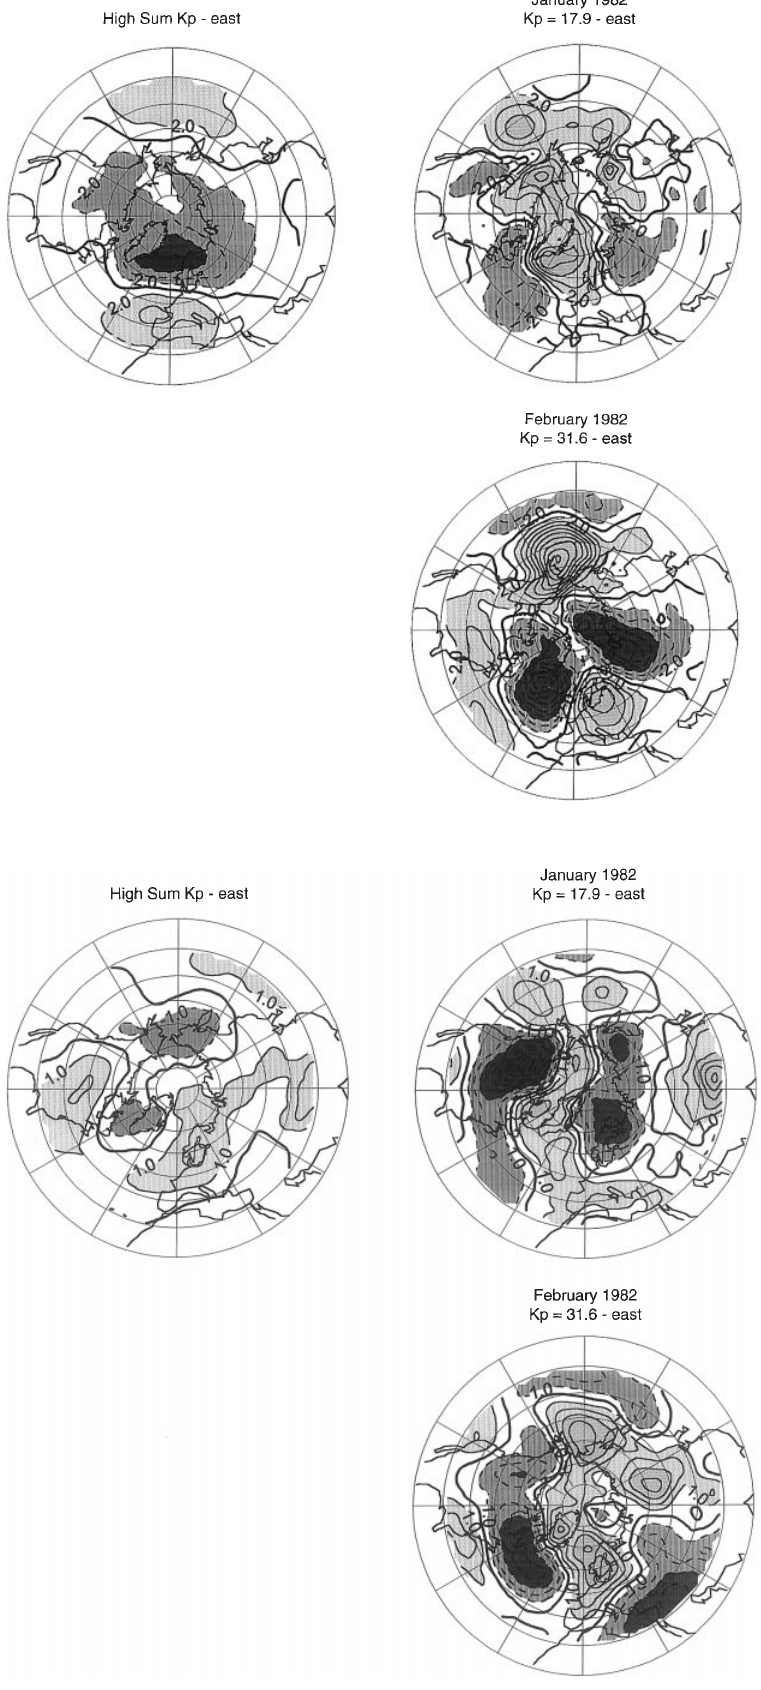
Fig. 6. Distribution of temperature deviations in individual months of winter period 1982 in com- parison with the composite map of temperature deviations at high sum Kp, QBO-east. The intervals between contours is 1